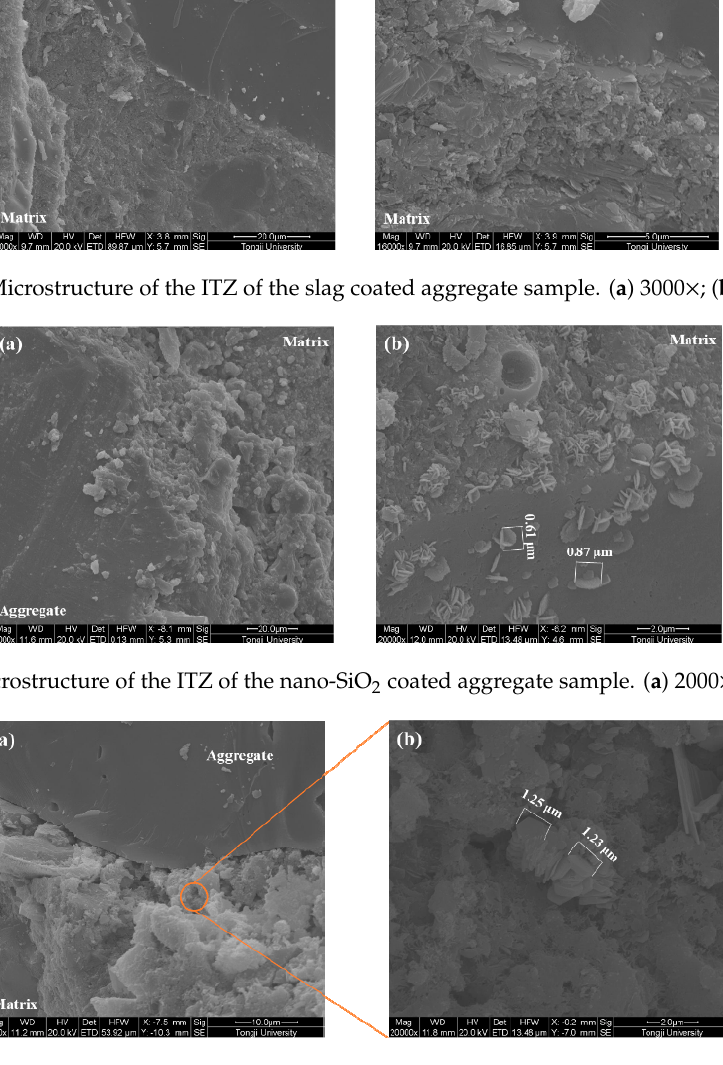
Figure 11. Microstructure of the ITZ of the nano-CaCO 3 coated aggregate sample. ( a ) 5000×; ( b ) 20000×.